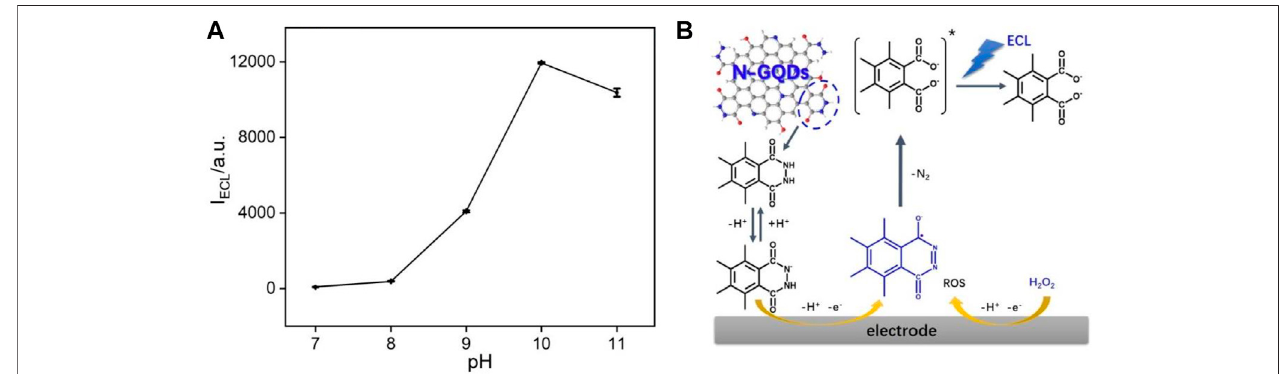
FIGURE 4 | (A) Effect of pH on ECL intensity of N-GQDs. (B) ECL mechanisms of